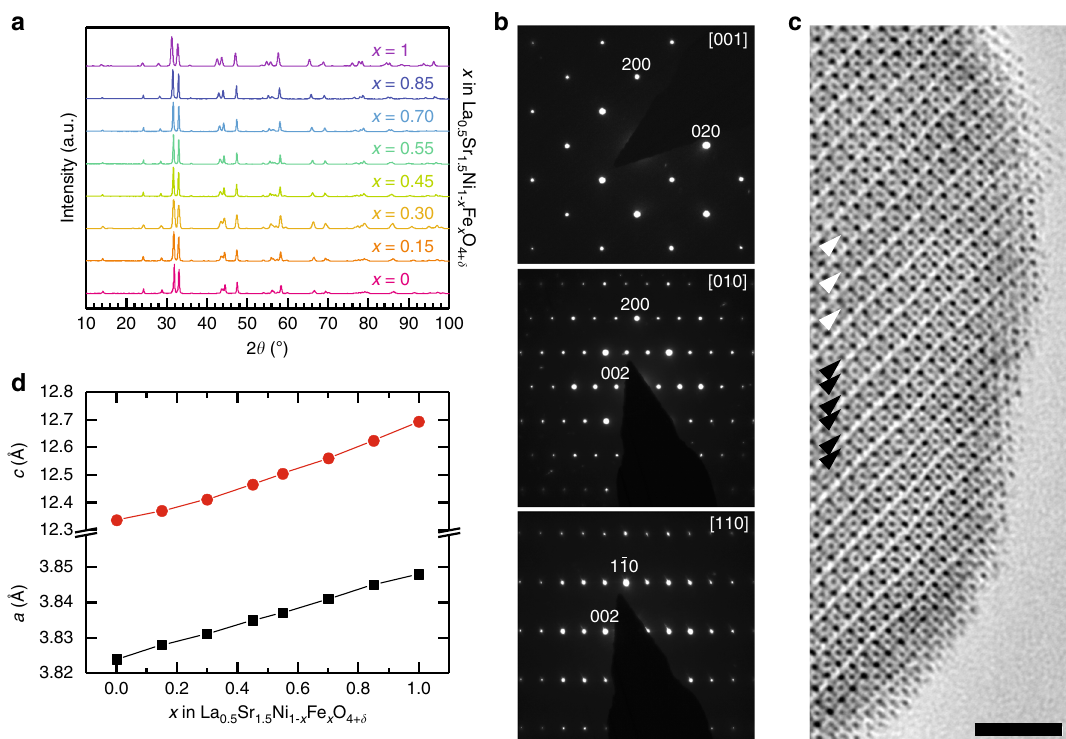
Fig. 1 Crystallographic characterization of the La 0.5 Sr 1.5 Ni 1 − x Fe x O 4 + δ series. a PXRD patterns of La 0.5 Sr 1.5 Ni 1 − x Fe x O 4 + δ demonstrate all compositions have the tetragonal n = 1 Ruddlesden – Popper I 4/ mmm structure. b Electron diffraction patterns of LSNF30 con fi rm the absence of cation and/or anion ordering. c [100] ABF-STEM image of LSNF30 directly visualizes the stacking of the (BO 2 ) octahedra (white arrowheads, B = Ni, Fe) and (AO)(OA) layers (black arrowheads, A = La, Sr) in the Ruddlesden – Popper structure. The scale bar is 2 nm. d Compositional dependence of a and c unit cell parameters showing 0 ≤ x ≤ 1 homogeneity